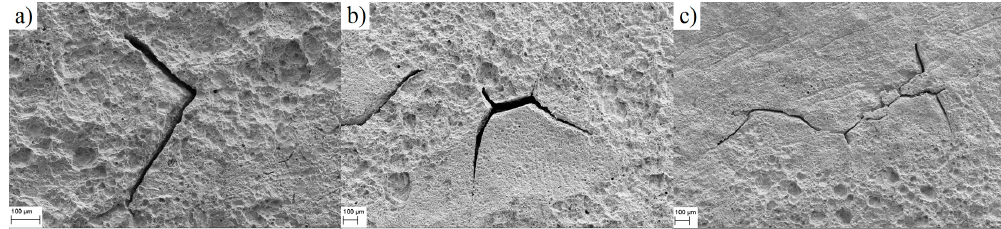
Figure 2. Different morphologies of star cracks on depression samples.